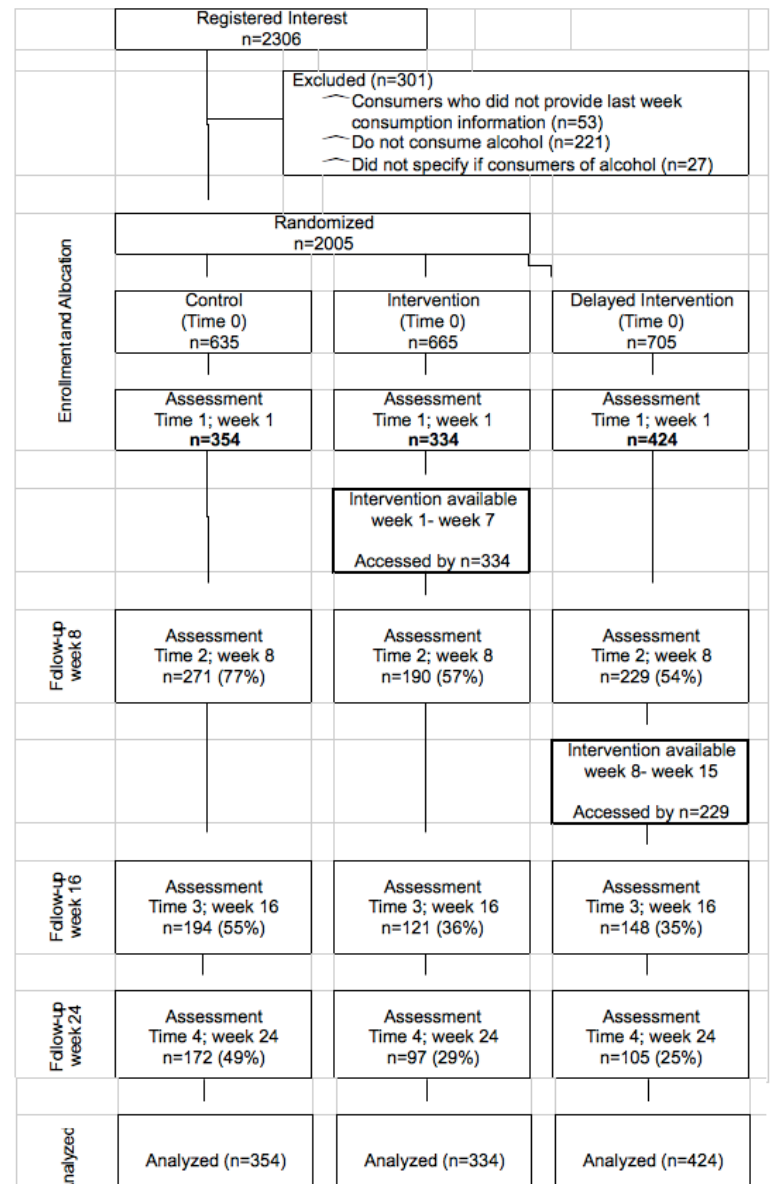
Figure 1. Participants flow through the